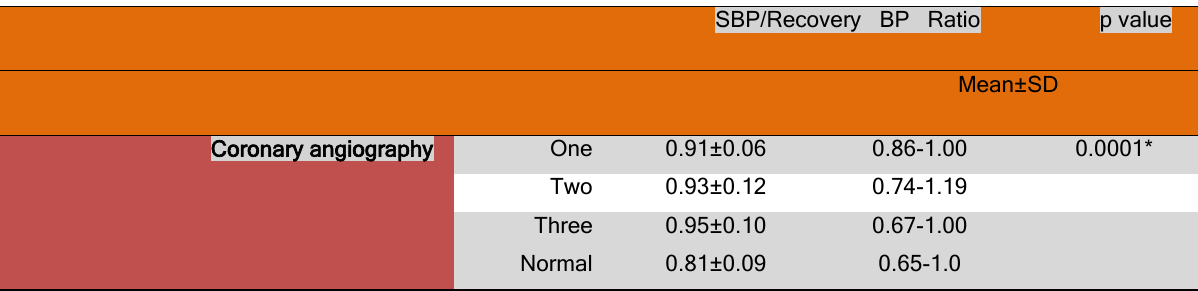
Table(5) relation of SBPR and numbers of vessels involve